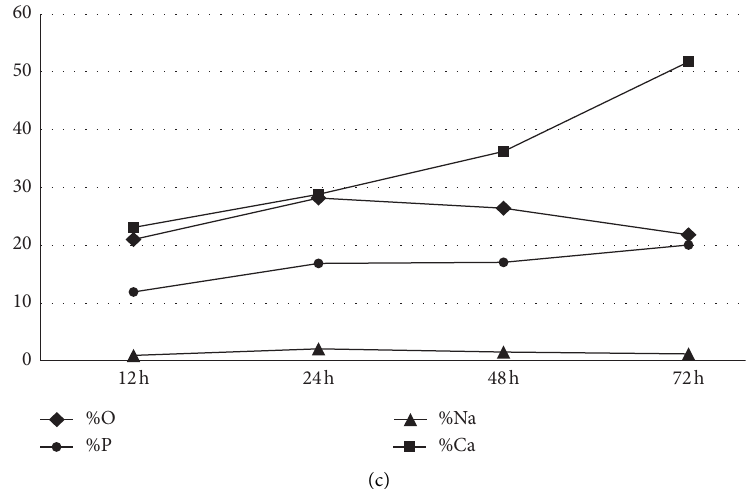
Figure 7: (a) Representative images by SEM highlighting the 3 different areas analyzed. (b) Representative spectrum obtained by EDS from a specimen immersed in SBF. (c) Elemental distribution by MEV/EDS as a function of